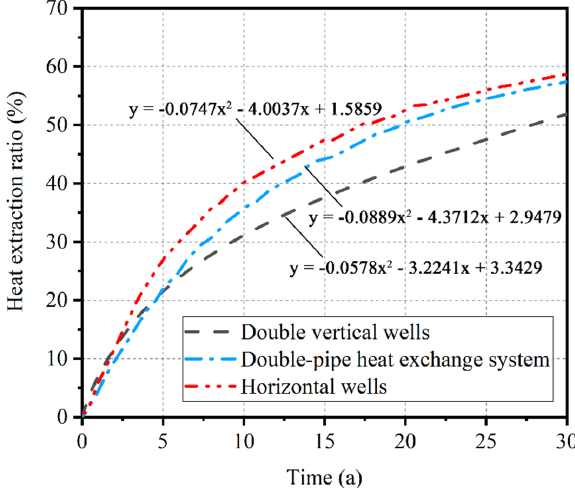
Figure 14. Heat extraction ratio curve.